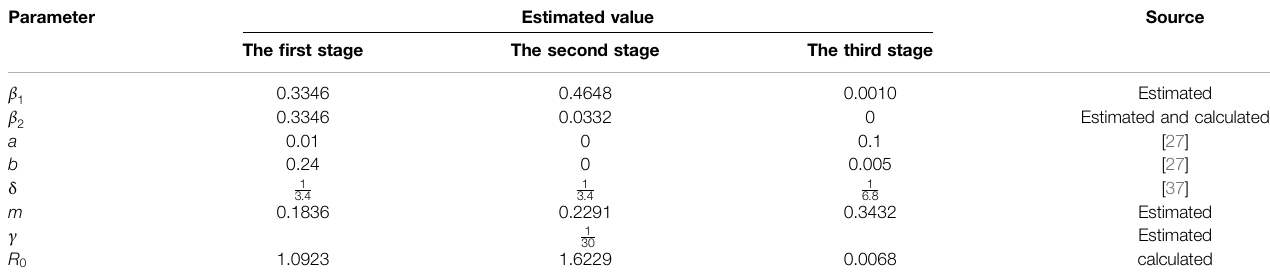
TABLE 2 | Parameter estimation of COVID-19 in Guangdong Province.